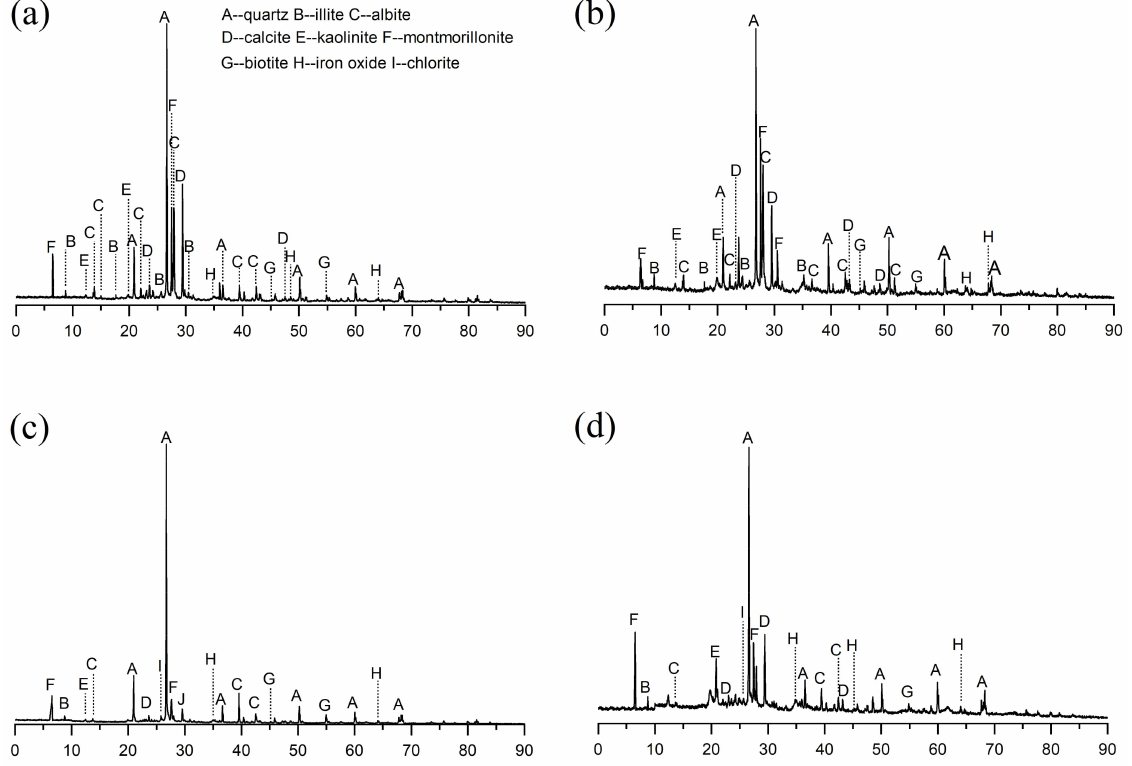
Figure 4. XRD analysis of soil samples: ( a ) 1-0; ( b ) 1-F; ( c ) 2-0; and ( d ) 2-F. Table 5. Mineral composition of